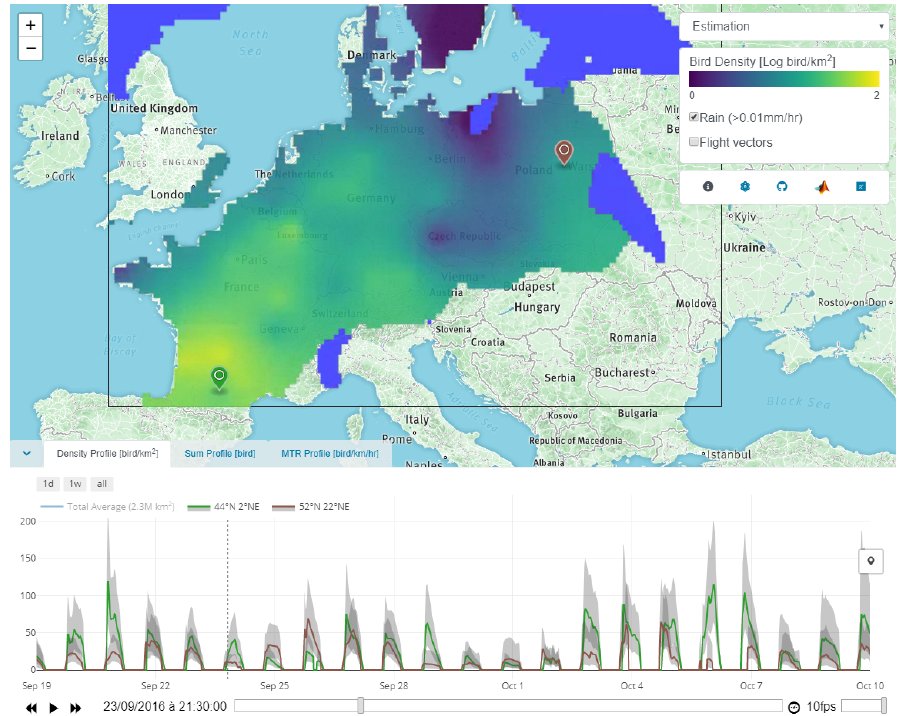
Figure A10. A print-screen of the web interface developed to visualize the dataset. The map shows the estimated bird densities for the 23 September 2016 at 21:30 with the rain mask appearing in light blue on top. The domain extent is illustrated by a black box. The time series in the bottom show the bird densities with quantile 10 and 90 at the two locations symbolized by the markers with corresponding color on the map. The button with a marker symbol on the right side of the time series allows users to query any location on the map and to display the corresponding time